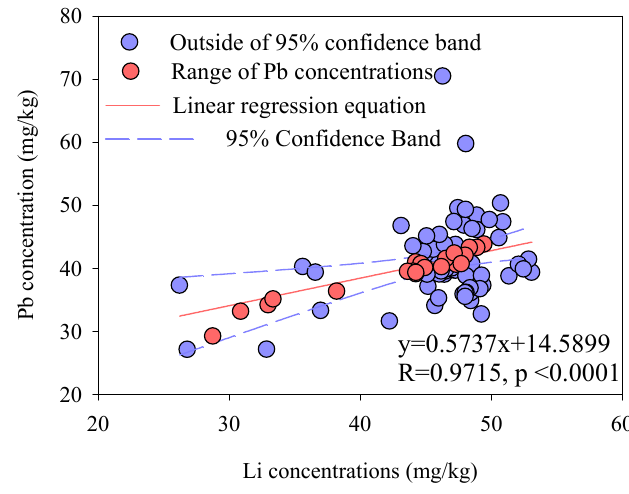
Figure 2. The process of establishing the RBG-Pb model.